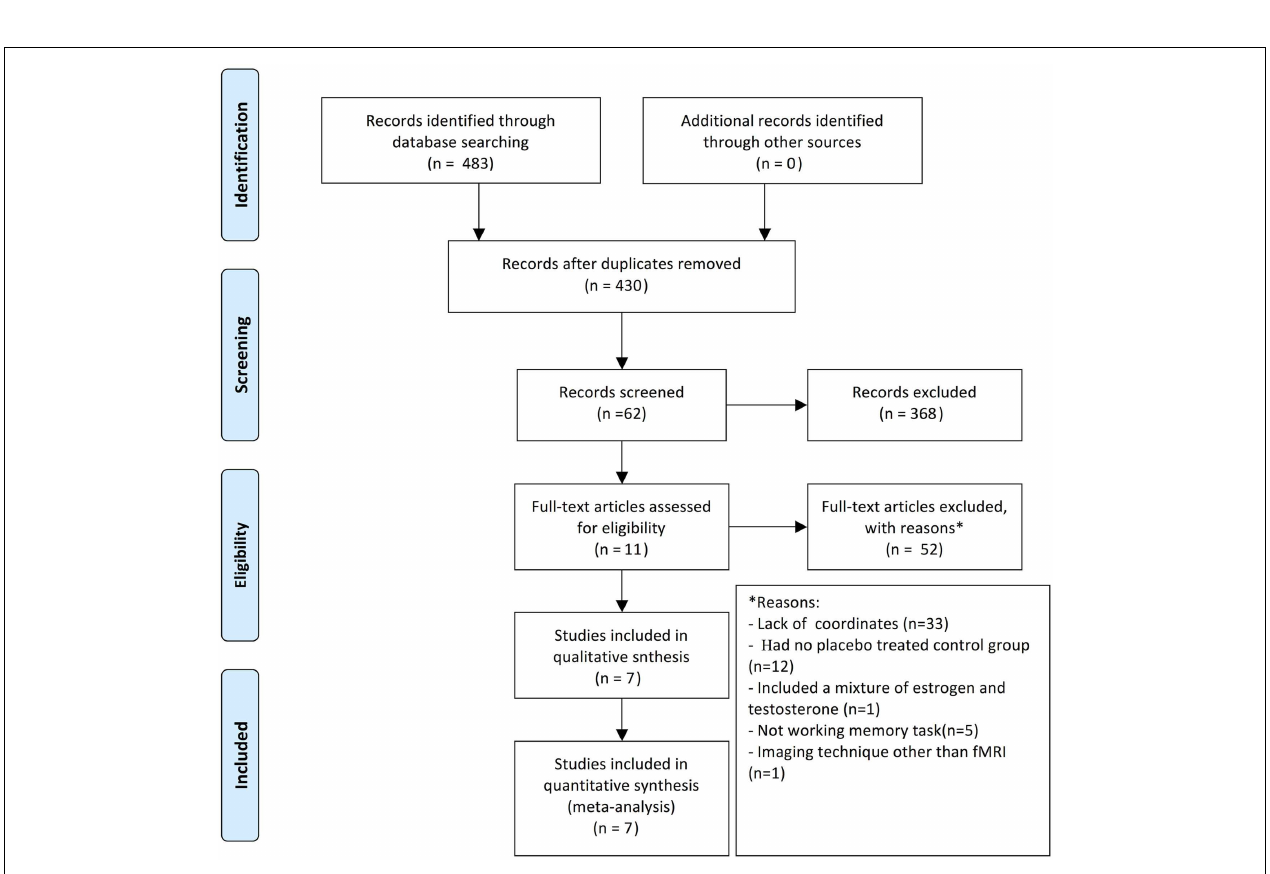
FIGURE 1 | Diagram of studies included in the present meta-analysis